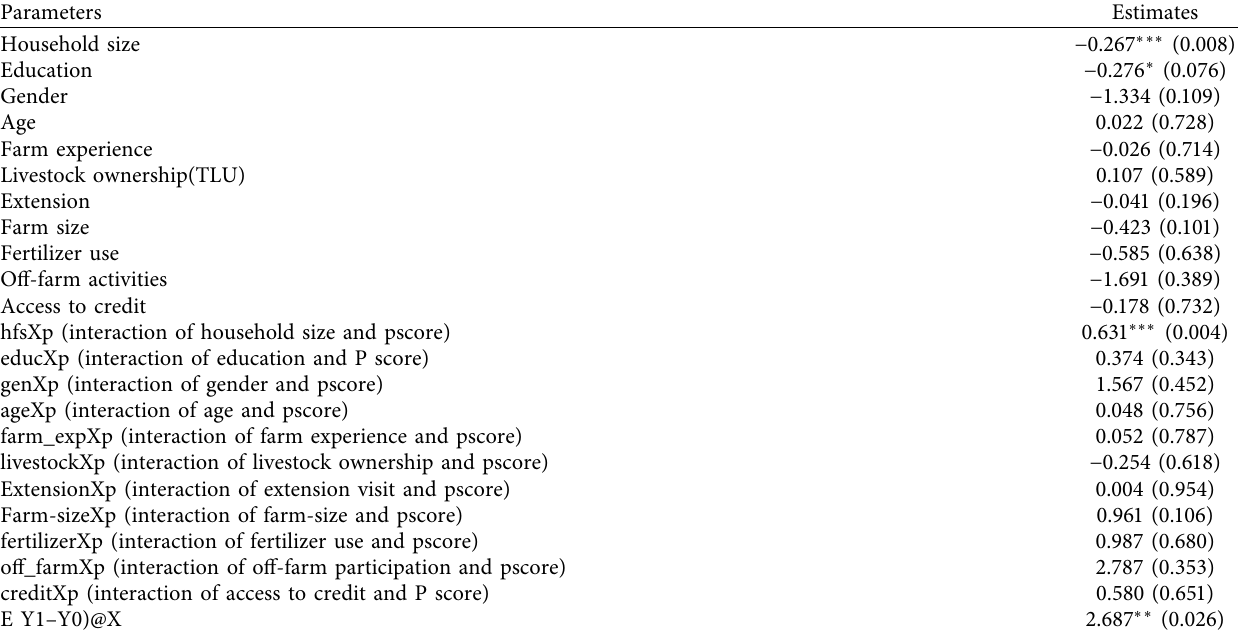
Figure 3: The common support of P (Z). Table 5: Determinants and impact of row planting semiparametric LIV